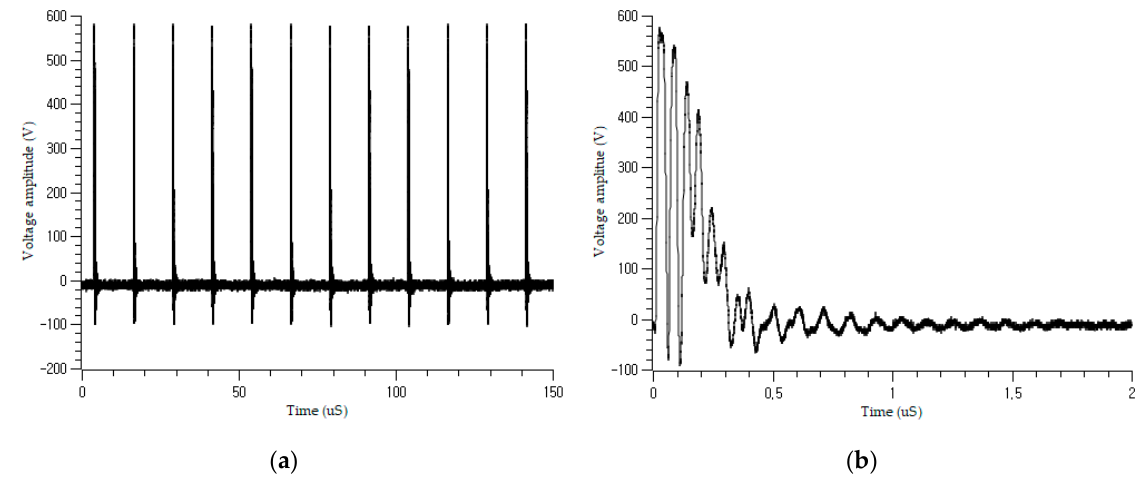
Figure 7. Offline burst signal injection on the cable: ( a ) coupled periodic burst signal; ( b ) a single pulse from ( a ).